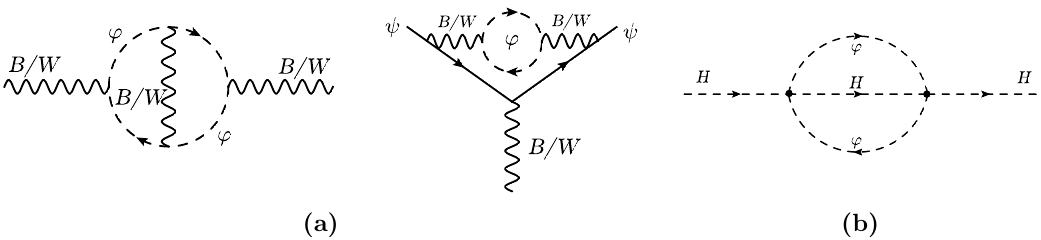
Figure 3. Sample Feynman diagrams showing two-loop contributions from the scalar (cid:12)eld ’ to gauge and Yukawa coupling beta functions. Figure (a) shows contributions to gauge coupling beta functions from gauge boson self-energies as well as ’ insertions to the three-point Green’s function with a single external gauge boson. Here, represents any fermion which couples to the gauge (cid:12)elds. Figure (b) shows a diagram from the two-loop Higgs self-energy which contributes to the Yukawa coupling beta